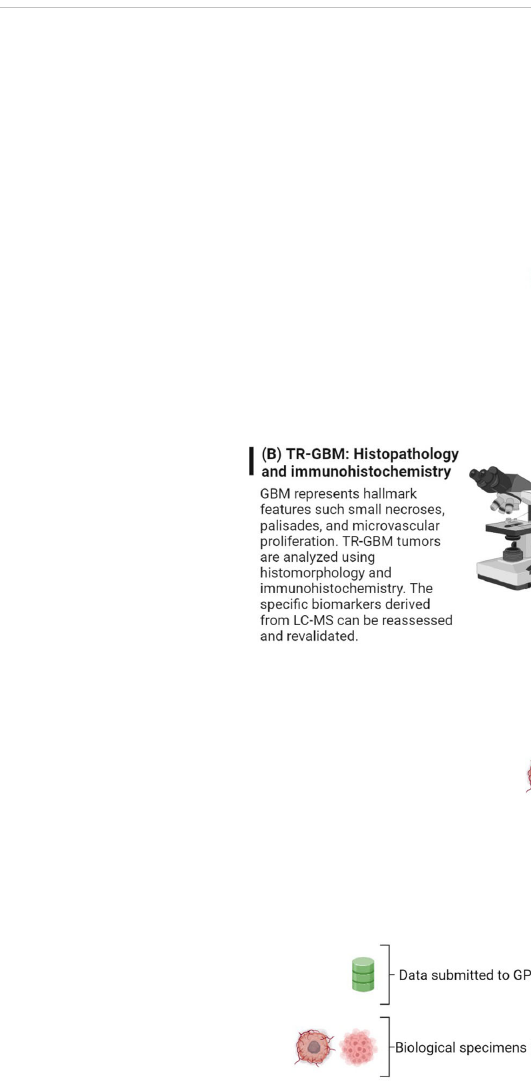
FIGURE 10 GPCCTR involves fi ve important steps: (A) TR-GBM tumor collection: TR tumors from patients during and after treatment will be collected, labeled, and stored as per the scienti fi c protocol. (B) TR-GBM histology: TR tumors will be tested for resistant speci fi c markers. (C) Genomic analysis of TR-GBM tumors: oncogenic alterations related to TMZ resistance will be analyzed. (D) LC-MS proteomic analysis of TR-GBM tumors: TR tumors will be sent to an LC-MS proteomics laboratory where the analysis is performed with established standard methodology. (E) GPCCTR central database: all of data from (A – D) will be submitted onto the portal. Data analysis and correlation will be performed on a cloud platform. All info and data would be open source and downloadable by registered